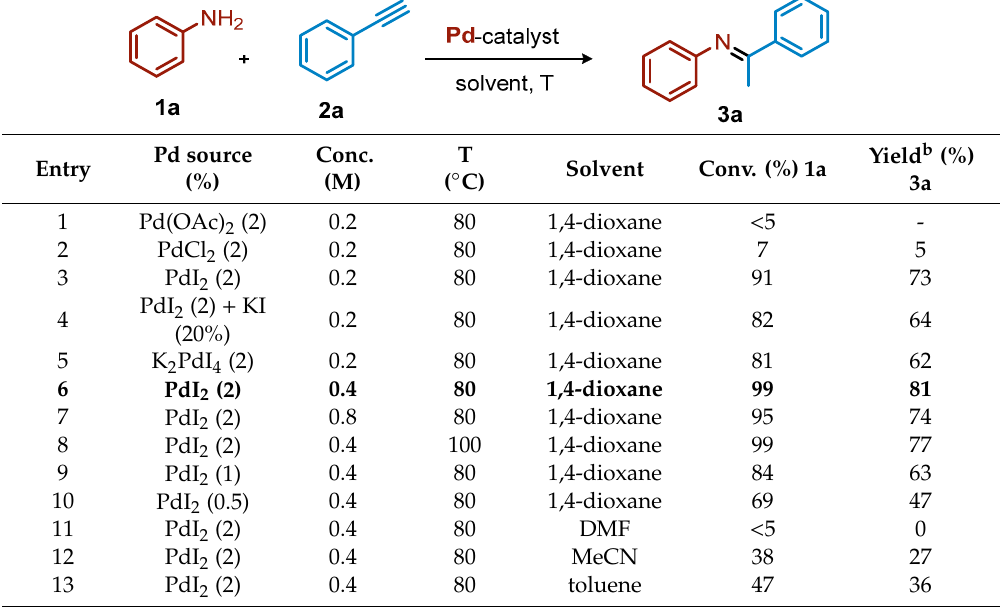
Table 1. Optimization study for the hydroamination of phenylacetylene with aniline a .